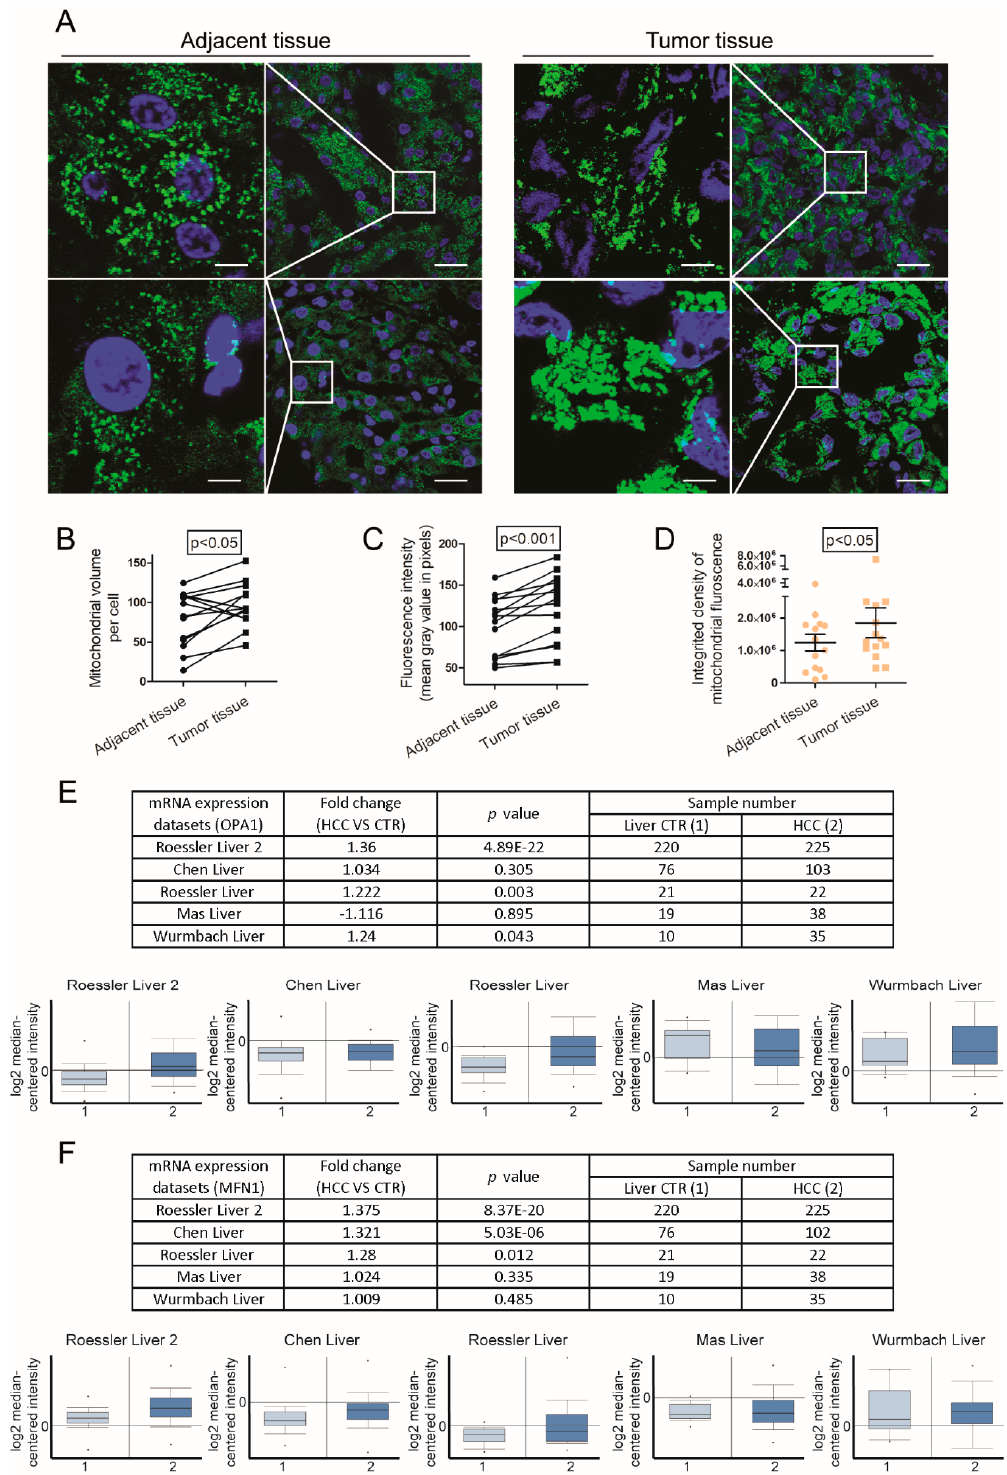
Figure 1. Activation of mitochondrial fusion in liver cancer. ( A ) Representative confocal images of mitochondria with VDAC1 staining in cryosection from paired tumor or adjacent liver tissues of two HCC patients. The white boxed regions were further magnified in the expanded images (left row). Scale bar = 5 µ m (left row). Scale bar = 20 µ m (right row). ( B ) Images of paired tissue were analyzed by ImageJ software. Mitochondrial volume per cell was determined by fluorescence area in pixels (Adjacent vs. Tumor: 80.29 ± 9.285 vs. 96.29 ± 7.24; n = 14 patients). ( C ) Fluorescent intensity represented the